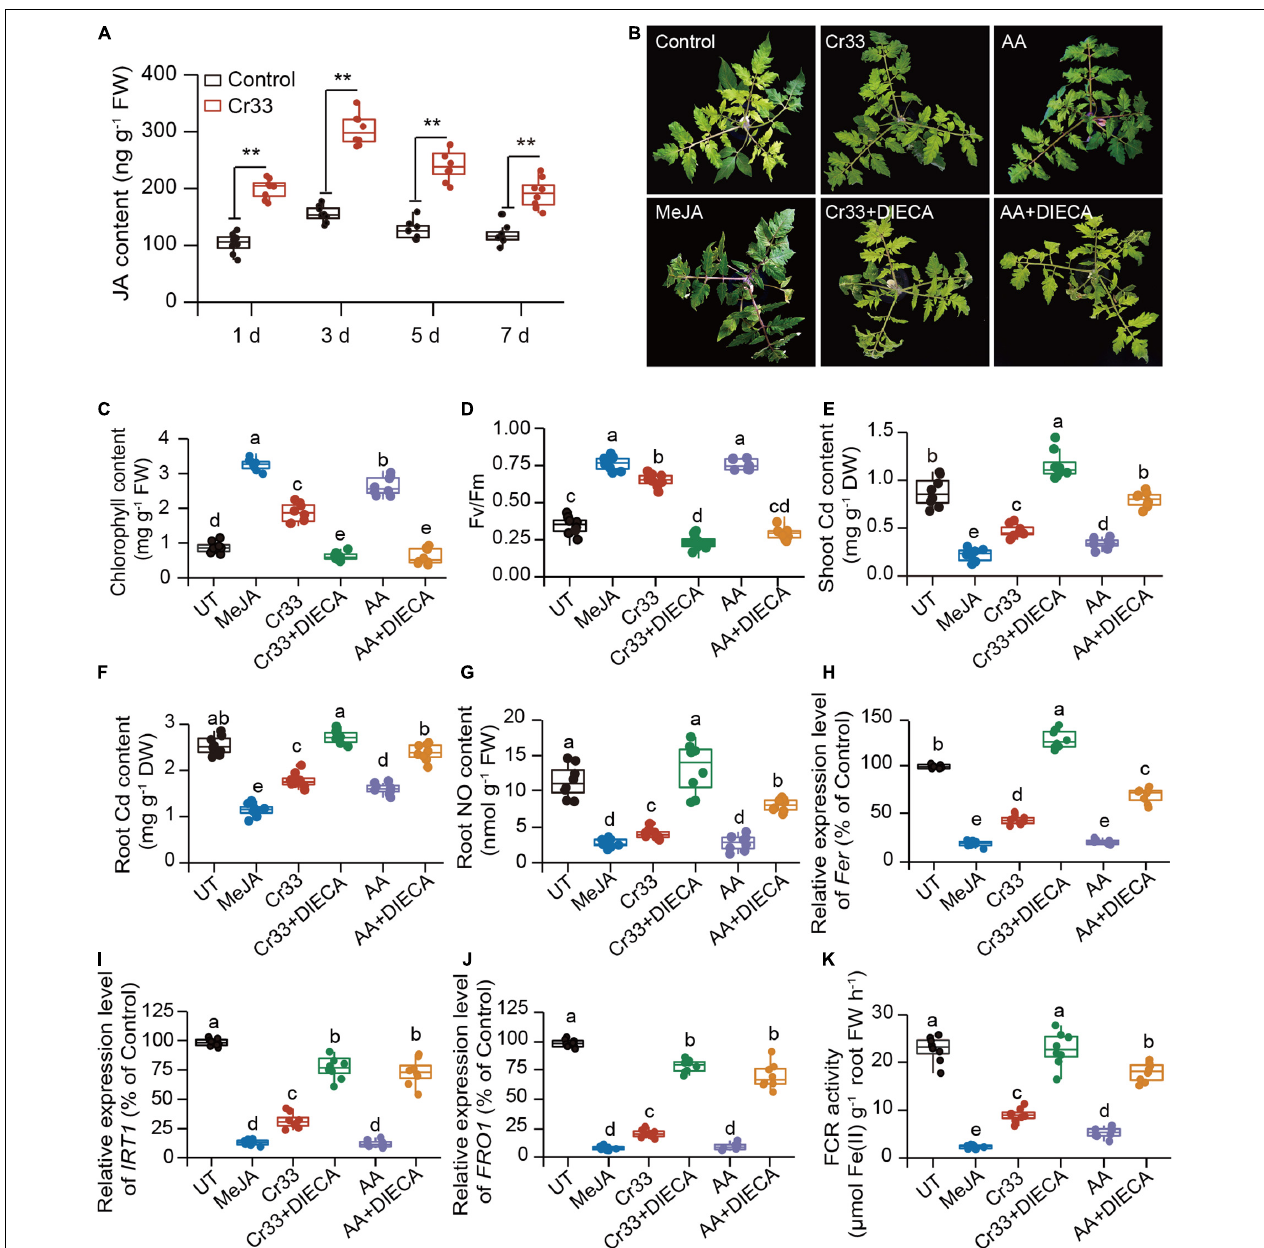
FIGURE 7 | Involvement of JA signals in the L. fusiformis Cr33-induced Cd resistance in tomato plants. (A) Root JA content within 7 d of Cd treatment. Asterisks indicated significant differences between the non-inoculated (control) and inoculated plants ( n = 8 biological replicates) using Student’s t -test (** p < 0.01). Three-weeks-old tomato plants were exposed to 100 µ M Cd with or without cell suspensions of Cr33 at the final density of 5 × 10 7 CFU mL − 1 , 0.15 mM acetic acid (AA), 0.05 mM MeJA, Cr33 plus 0.2 mM DIECA (Cr33 + DIECA), and 0.15 mM AA plus 0.2 mM DIECA (AA + DIECA) for 20 d. The untreated (UT) and treated plants were used to analyze shoot phenotypes (B) , chlorophyll content (C) , Fv/Fm values (D) , shoot (E) and root (F) Cd content, root NO content (G) . qPCR analyses of the expression of Fer (H) , IRT1 (I) and FRO1 (J) , and root FCR activity (K) after 48 h of treatments. Different letters indicated significant differences among different experimental groups ( n = 8 biological replicates) using Duncan’s multiple range test at p <